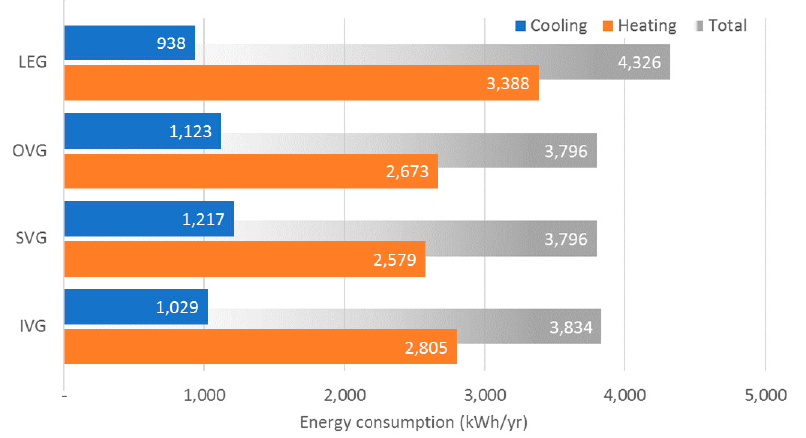
Figure 15. Calculated cooling and heating energy consumption of residential building.